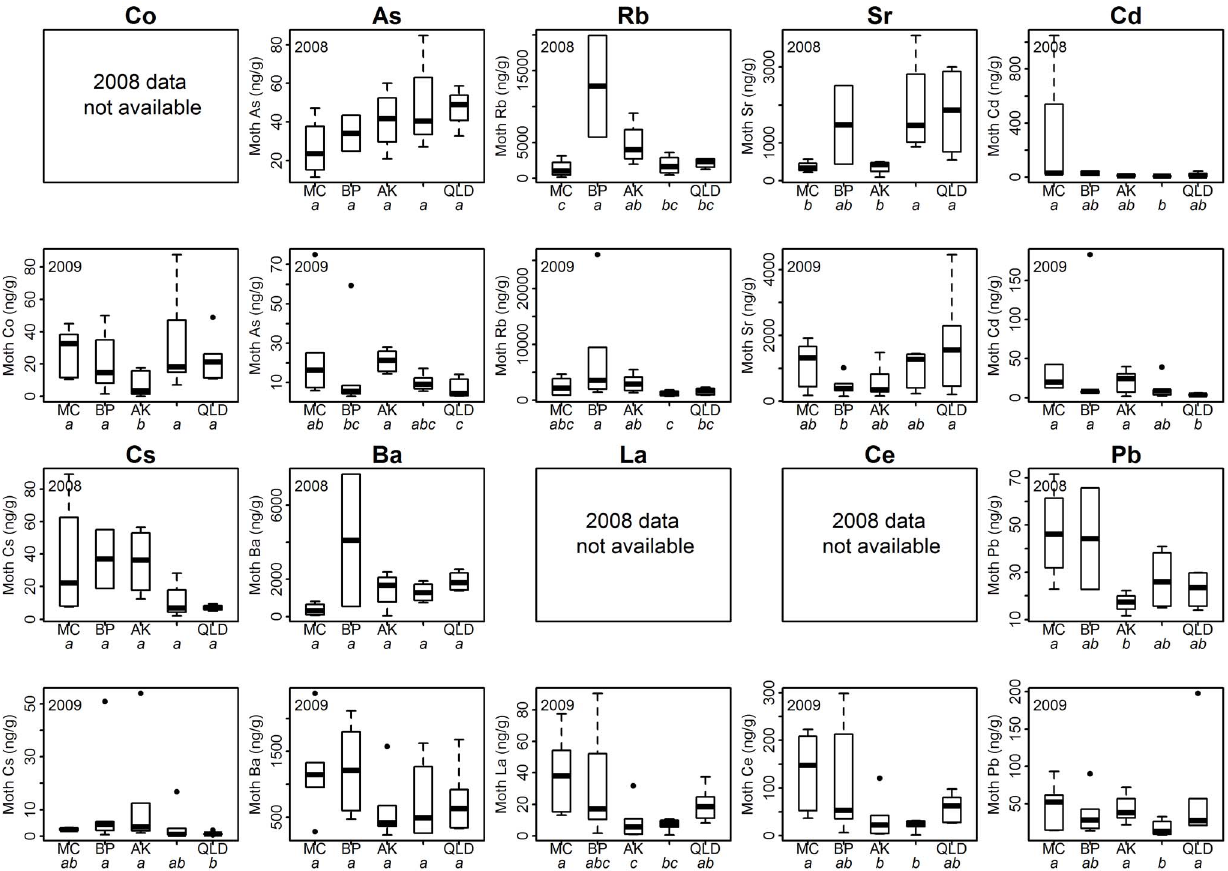
Figure 6. Trace element concentration data for H.armigera . Only the most informative elements are shown. Data is displayed as median, quartiles and the minimum/maximum value within 1.5 inter-quartile range; values outside 1.5 IQR are designated by a circle. Regions assigned a different lower case italic letters are significantly different (Fishers unrestricted LSD =5%). ‘Data not available’ = information for that element was not recorded or lost due to analytical error.